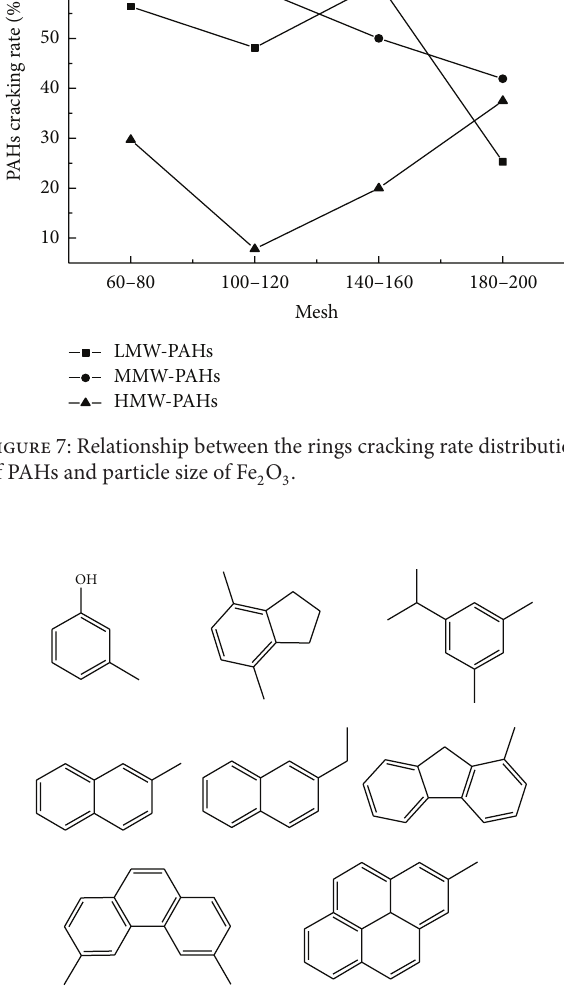
Figure 8: Portion products from coal